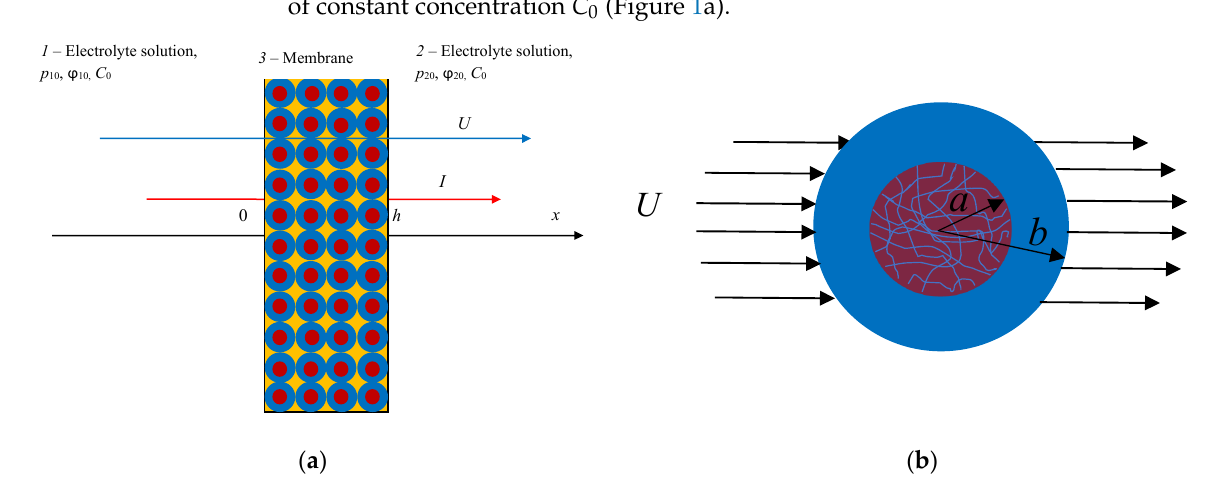
Figure 1. Diagram of the electrolyte solution transfer process through a charged porous layer (membrane) ( a ) and single cell ( b ).